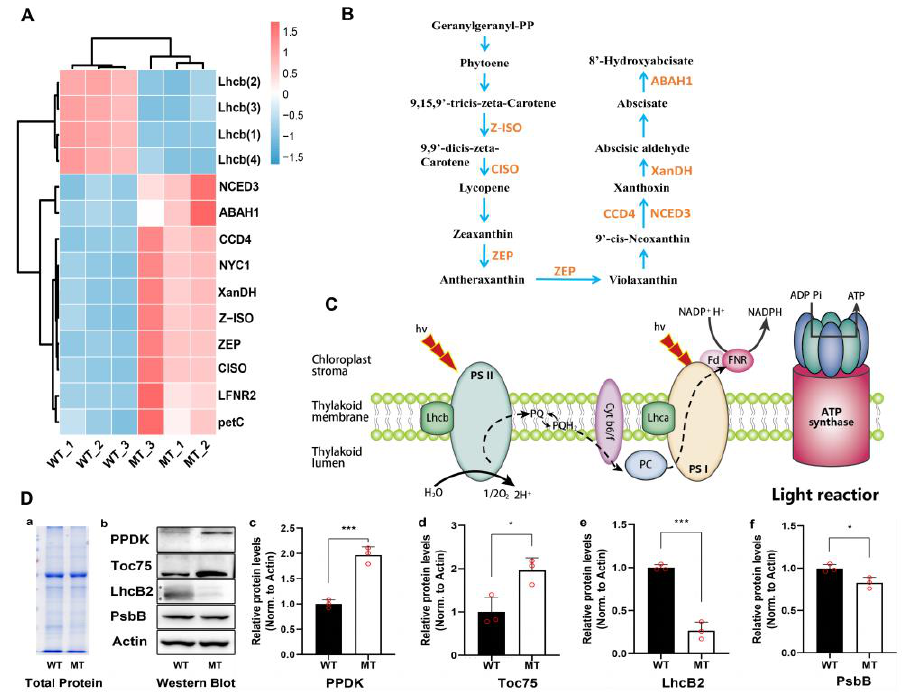
Figure 8. Analysis of DAMs, DEGs and DAPs in the metabolic pathways related to photosynthesis. ( A ) Relative expression level of DEGs in light reactions and carotenoid biosynthesis. Lhcb, light- harvesting complex of PSII; LFNR2, ferredoxin–NADP reductase leaf isozyme; petC, cytochrome b6-f complex iron-sulfur subunit. NYC1, chlorophyll(ide) b reductase; CCD4, carotenoid cleavage dioxy- genase 4; ZEP, zeaxanthin epoxidase; XanDH, xanthoxin dehydrogenase; Z-ISO, 15-cis-zeta-carotene isomerase; NCED3, 9-cis-epoxycarotenoid dioxygenase; ABAH1, abscisic acid 8 (cid:48) -hydroxylase 1-like; CISO, prolycopene isomerase. ( B ) Carotenoid metabolism pathway. ( C ) Light reaction stage. Lhcb, light harvesting complex of PSII; PQ, plastoquinone; Cyt b6/f, cytochrome b6/f; PC, plastocyanin; Lhca, light harvesting complex of PSI; Fd, ferredoxin; FNR, ferredoxin-NADP+ reductase. ( D ) Relative quantitative analysis of proteins. a, total protein gel staining map; b, western Blot diagram; c, quantitative results of PPDK (pyruvate phosphate dikinase); d, quantitative results of Toc75 (chloroplast outer envelope mebrane translocon complex OEP75 protein); e, quantitative results of of LhcB2 (LHCII type chlorophyll a/b-binding protein); f, quantitative results of PsbB (PSII CP47 reaction center protein). All the analyses used WT as a control, and relative quantitative analysis of proteins using Actin protein as internal reference. * and *** indicate significant differences (0.01 < p < 0.05, p < 0.001).